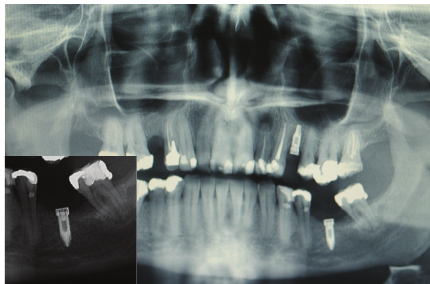
Figure 2: Panoramic radiograph showing the presence of a dental implant in the lower left molar region. Insert: increased magnifica- tion focusing on the implant in the region of the lower left molar, showing lack of radiographic features that would be compatible with bone involvement.